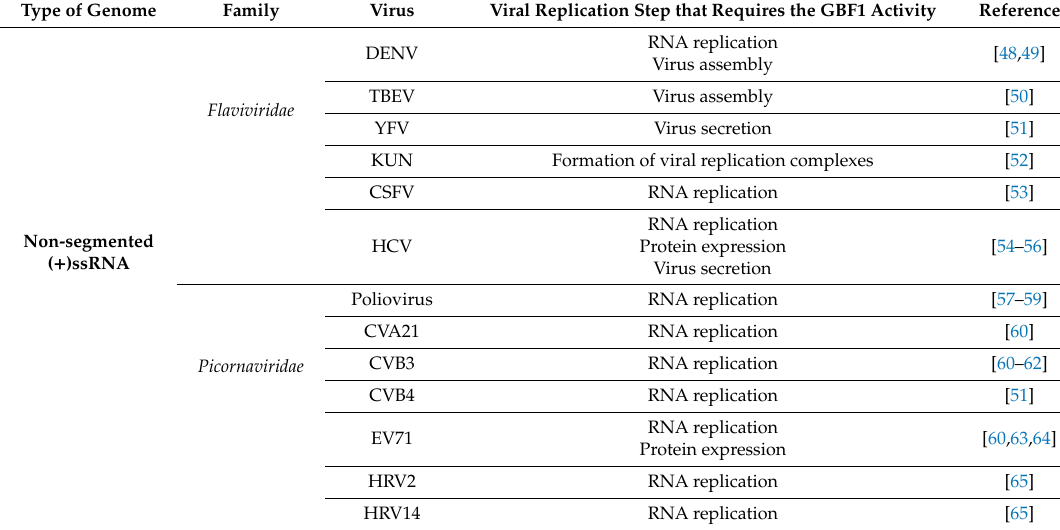
Table 1. Role of GBF1 in the replication of RNA viruses.